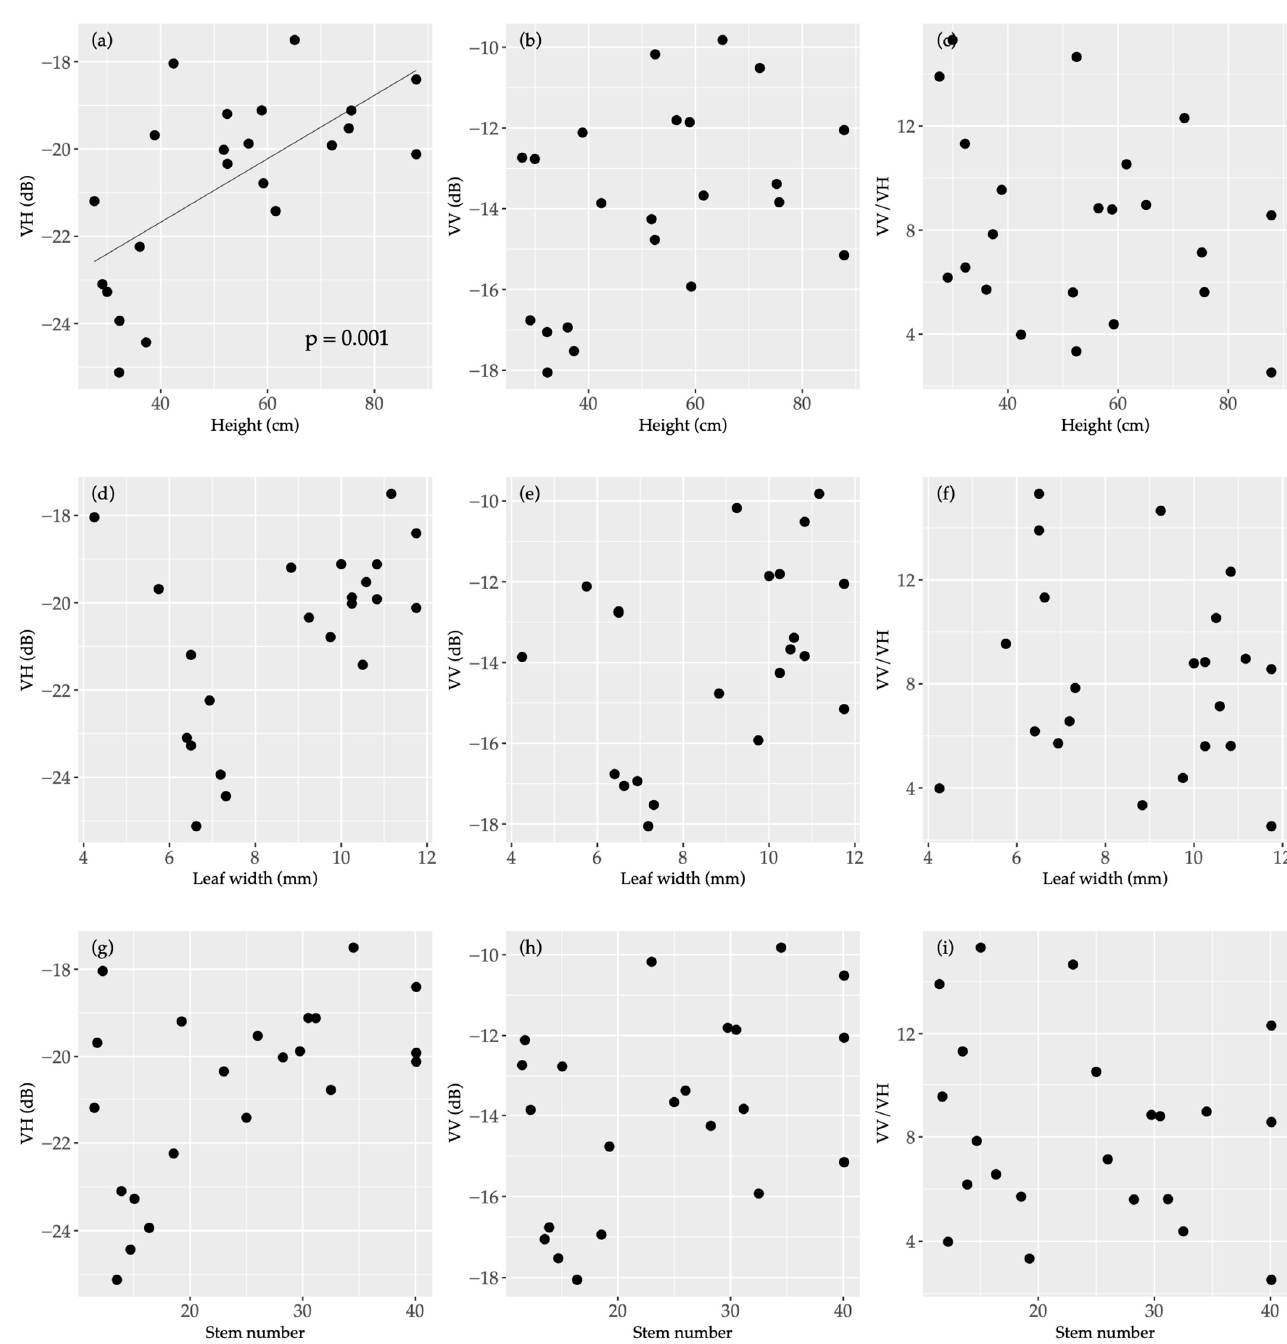
Figure 6. Scatterplots of field-observed biophysical parameters in the vegetative stage and microwave backscatter values from orb 39. Plant height (cm), maximum leaf width (mm), and stem number were measured in the tillering stage. The leftmost column depicts VH, the center shows VV, and the rightmost presents VV/VH. ( a – c ) plant height, ( d – f ) maximum leaf width, and ( g – i ) stem number, respectively.